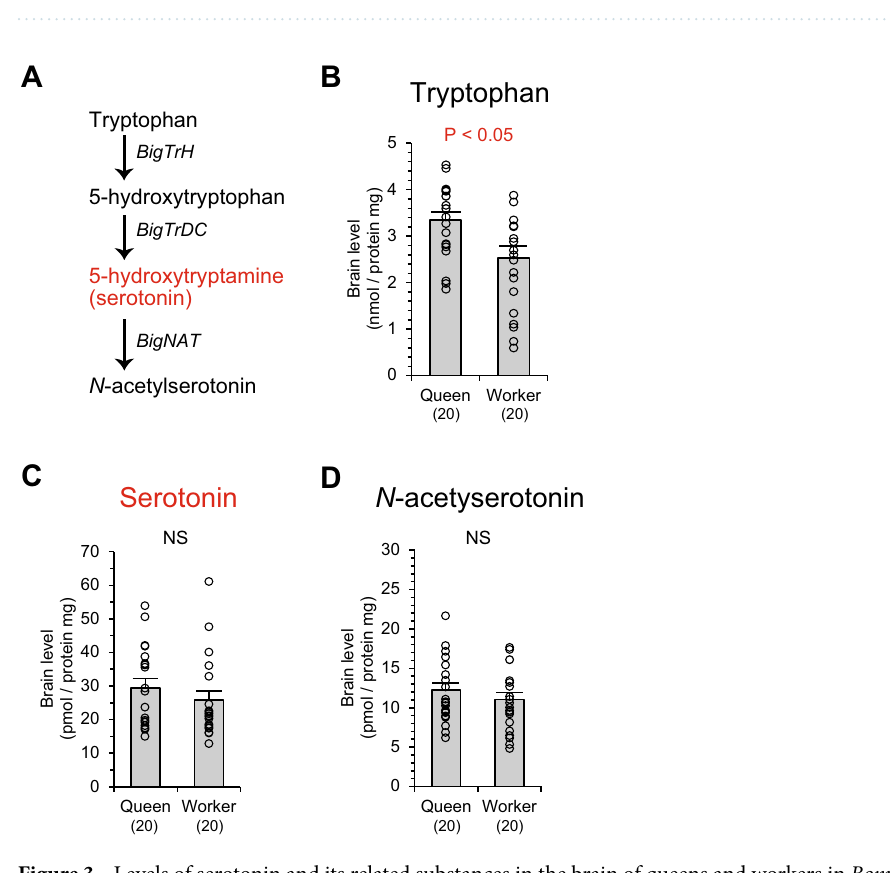
Figure 2. Levels of tyramine and octopamine in the brains of queens and workers in Bombus ignitus . A metabolic pathway of phenolamines is indicated ( A ). Octopamine is synthesized from tyrosine via tyramine. Enzyme genes mediating the biosynthetic reaction are indicated in italics. Tyramine and octopamine are functional monoamines (red). Levels of tyramine ( B ) and octopamine ( C ) in the brains of queens and workers are indicated. Numbers in parentheses indicate the number of samples examined. Data were obtained from 10 individuals in each caste per colony (two colonies). Individual data of biogenic amine levels were indicated by plots in graphs and in Table S7.